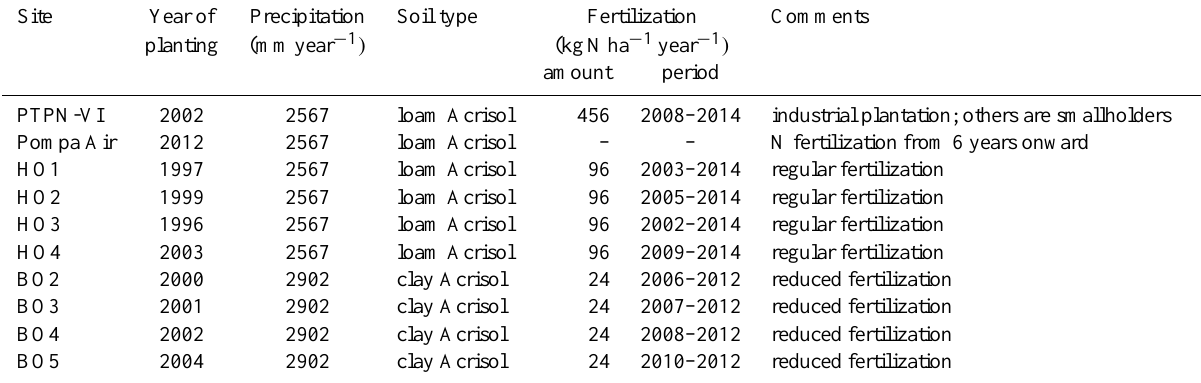
Table 1. Site conditions and N-fertilization records at the calibration and validation plots. Site Year of Precipitation Soil type Fertilization Comments planting (mmyear − 1